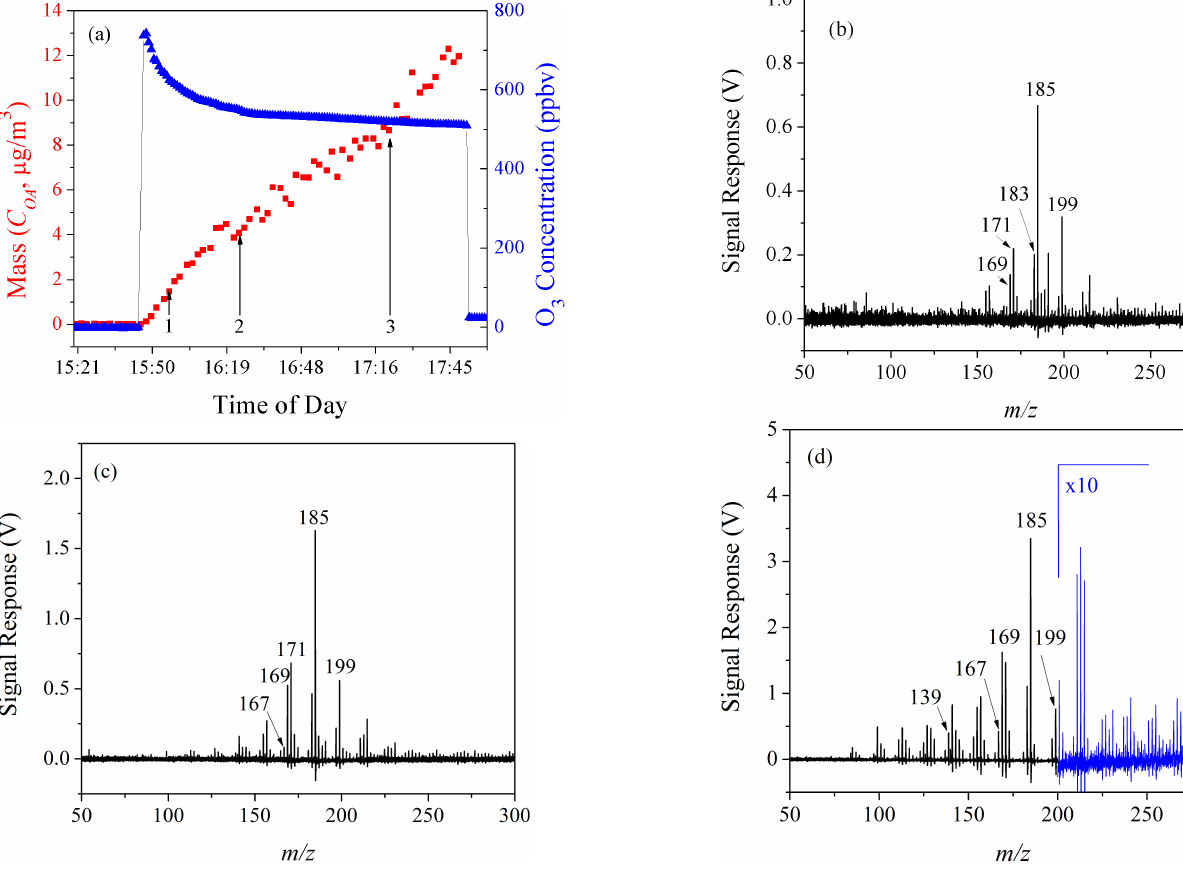
Fig. 3. Typical time-course data recorded during SOA formation in chamber from α -pinene ozonolysis, including (a) total aerosol mass loading ( (cid:4) ), C OA , ozone concentration ( N ) and NIR-LDI mass spectra at three different time points along the SOA growth curve; (b) Time point 1 with C OA = 1 . 5µgm − 3 ; aerosol (number) geometric mean diameter of 132nm and standard deviation of 1.31; (c) Time point 2 with C OA = 4 . 1µgm − 3 ; aerosol (number) geometric mean diameter of 168nm and standard deviation of 1.30; (d) Time point 3 with C OA = 8 . 7µgm − 3 ; aerosol (number) geometric mean diameter of 197nm and standard deviation of 1.30. Each mass spectrum is the result of a single, 2-min aerosol sampling into the